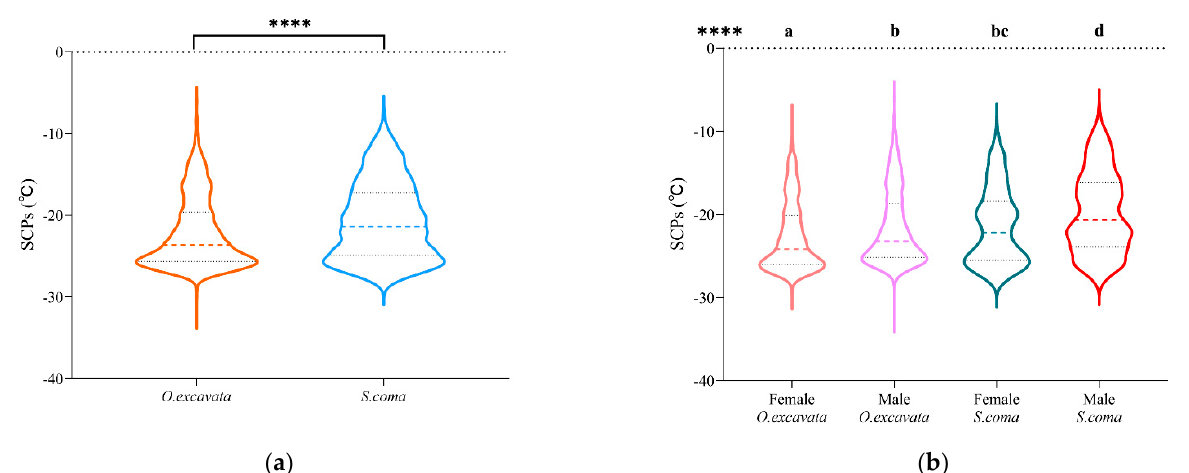
Figure 1. The distribution and difference of supercooling points (SCPs) between the solitary bee O. excavata and the brood parasite S. coma from 50 villages collected in December 2017, in the north part of the Jiaodong peninsula district, Shandong Province, China. The four asterisks denote significant difference ( p < 0.0001) using the Mann-Whitney test ( a ) and significant difference ( p < 0.0001) using the Kruskal-Wallis test ( b ). Bars with different superscripts denote significant differences ( p < 0.0001) using Dunn’s multiple comparisons test ( b ). The dashed lines indicate medians in the middle and quartiles on both sides of the violin plots.